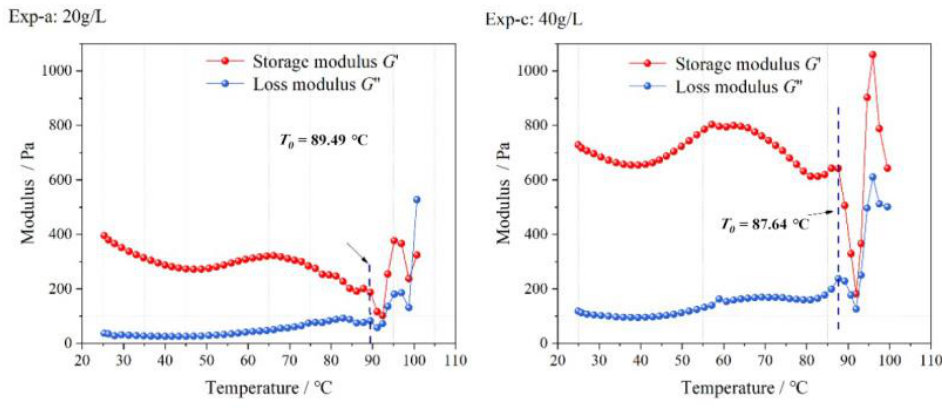
9 of 21 Figure 7. Viscosity with increasing temperature at pH values of 6 and 9. When the temperature was low, slight changes occured in G’ and G”. When the tem- perature reached a specific value, both the values of G’ and G” produced large irregular vibrations due to the gradual loss of colloid moisture and gradual transformation from colloid to solid, leading to inaccurate results in the rheology tests. The modulus value was defined as the mutation point value, the ratio of the difference between which the maxi- mum value to the maximum value was greater than 15%. The temperature corresponding to the mutation point was recorded as T 0 . Therefore in this paper, only the data before T 0 are discussed. 2.3.2. Rheological Properties at Different Ca-Bt Contents The results in Section 2.2.2 showed that Na-Bt had no significant effect on the sol-gel transition of the LMP-Bt colloid. The contents of Ca-Bt and LMP were changed in the rhe- ology tests. The elastic modulus and viscosity of the LMP-Bt colloid with different Ca-Bt contents was measured with the pH value fixed at 6. Figures 6 (Exp-b) and 8 show the